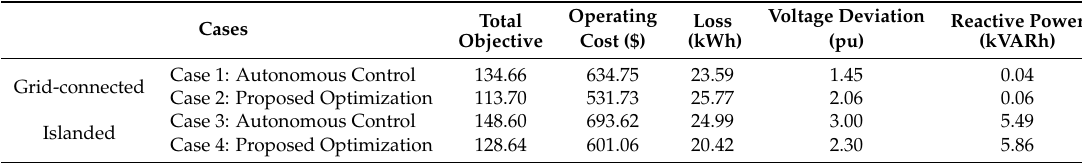
Table 3. Costs of the community microgrid in different